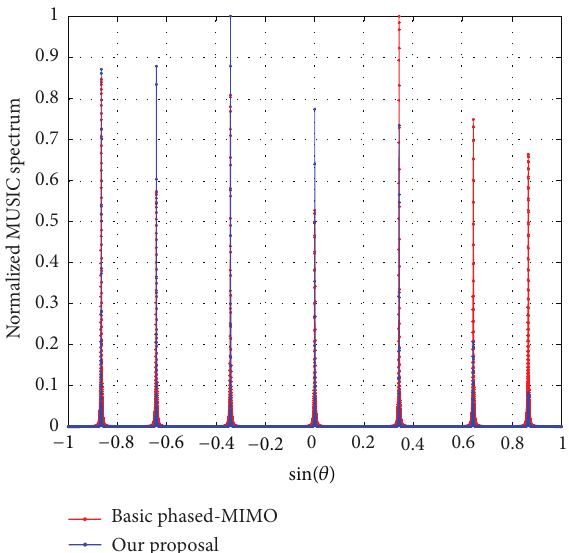
Figure 5: Comparative MUSIC spectra when 𝐿 = 7 .